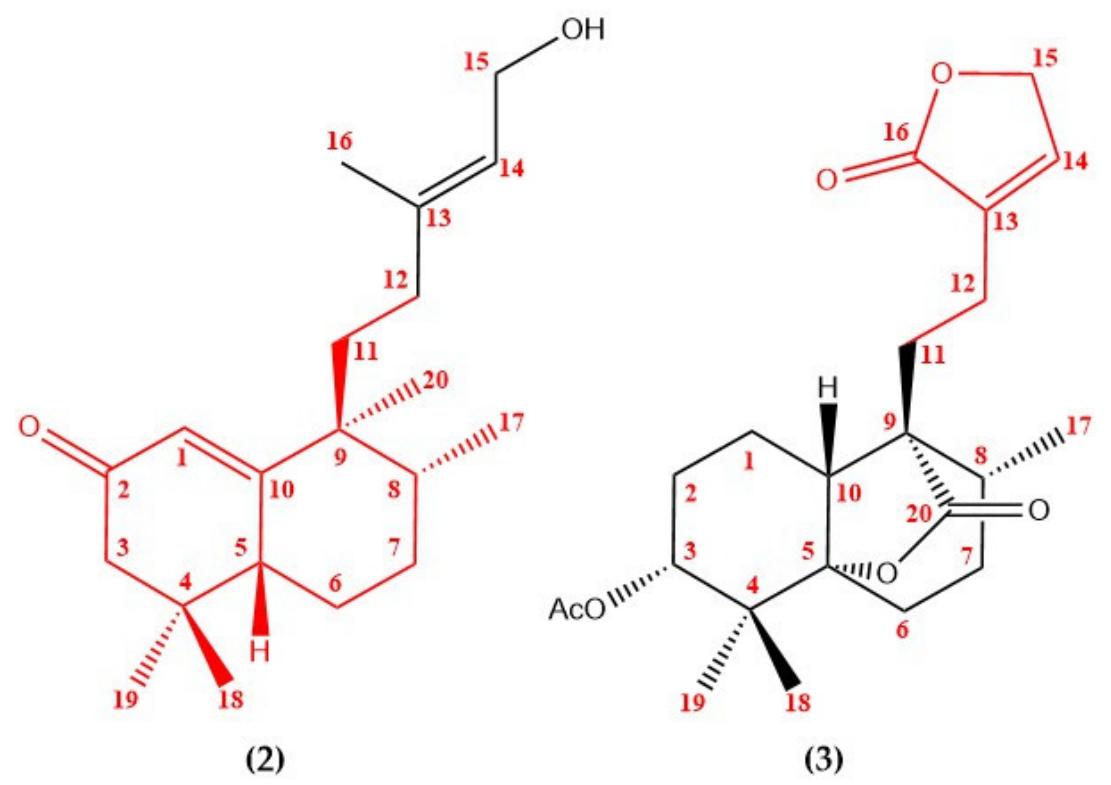
Figure 3. Structures of reference halimane diterpenoids displaying red coloured moieties common to 1 . ( 2 ) 2-oxo-friedolabd-1(10),13 E -dien-15-ol; ( 3 ) acetic acid (1 S ,3 R ,6 R ,7 R ,8 R )-2,2,8-trimethyl-12-